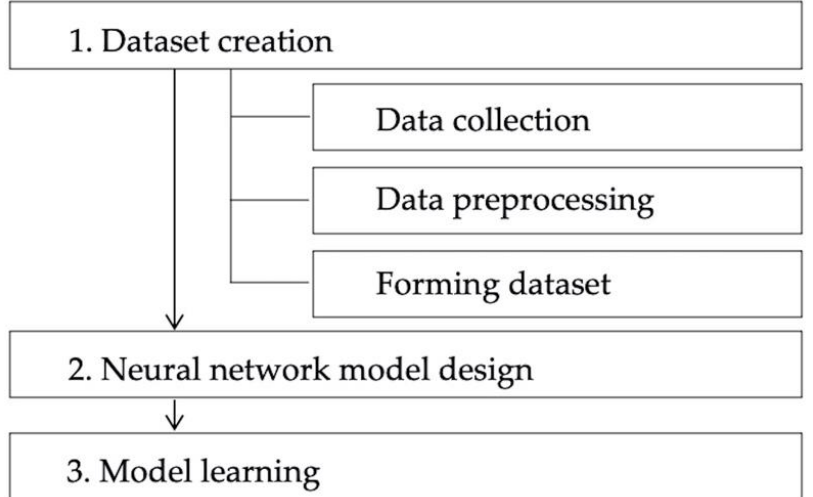
Figure 2. Steps to develop the myopotential estimation model.